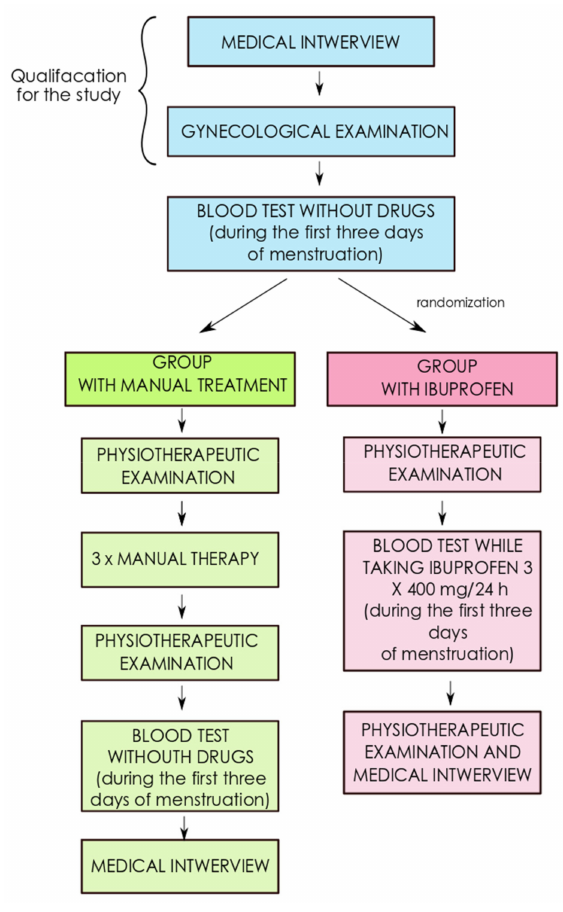
Figure 1. Participant flow